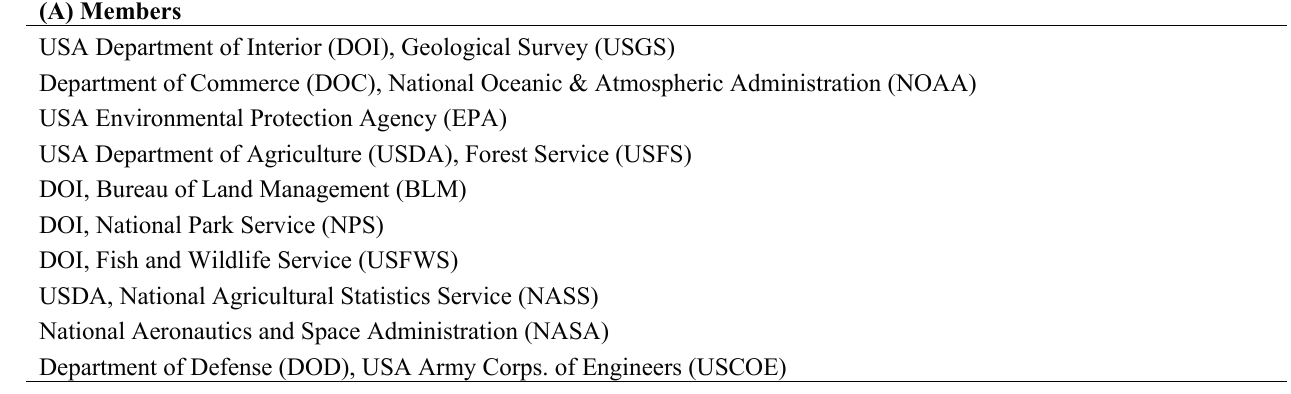
Table 1. Multi-Resolution Land Characteristics (MRLC) Consortium members ( A ) and products ( B ). Under products (B), temporal extent refers to the nominal date of satellite acquisition, not the release